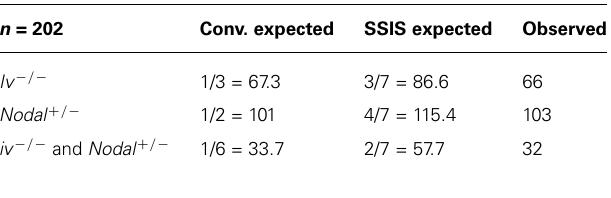
Table 3 |Allele frequencies in offspring of iv + / − Nodal + / − × iv − / − Nodal + / +